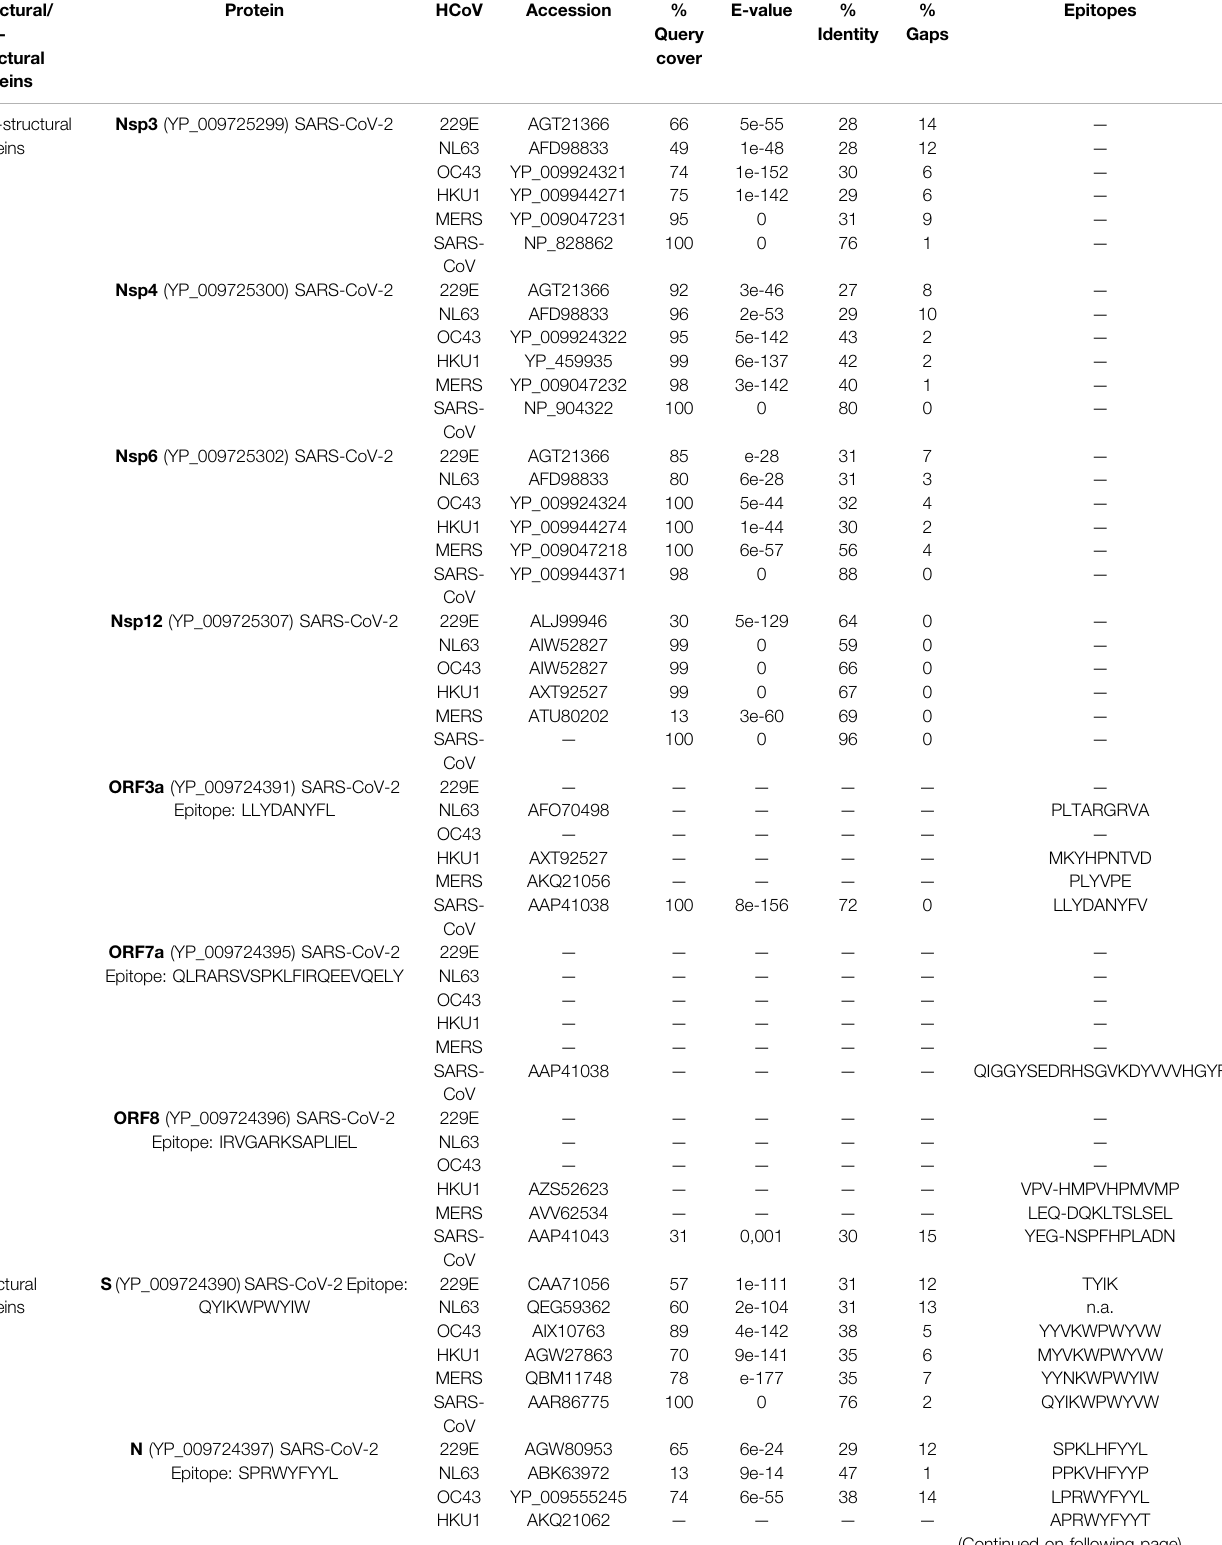
TABLE 2 | Protein sequence alignment results. Amino acid sequence alignment between the mentioned SARS-CoV-2 proteins and the other HCoVs. “—” in the column “ Epitopes ” indicates that no epitope has been reported in IEDB. Structural/ Protein Non- structural proteins Non-structural